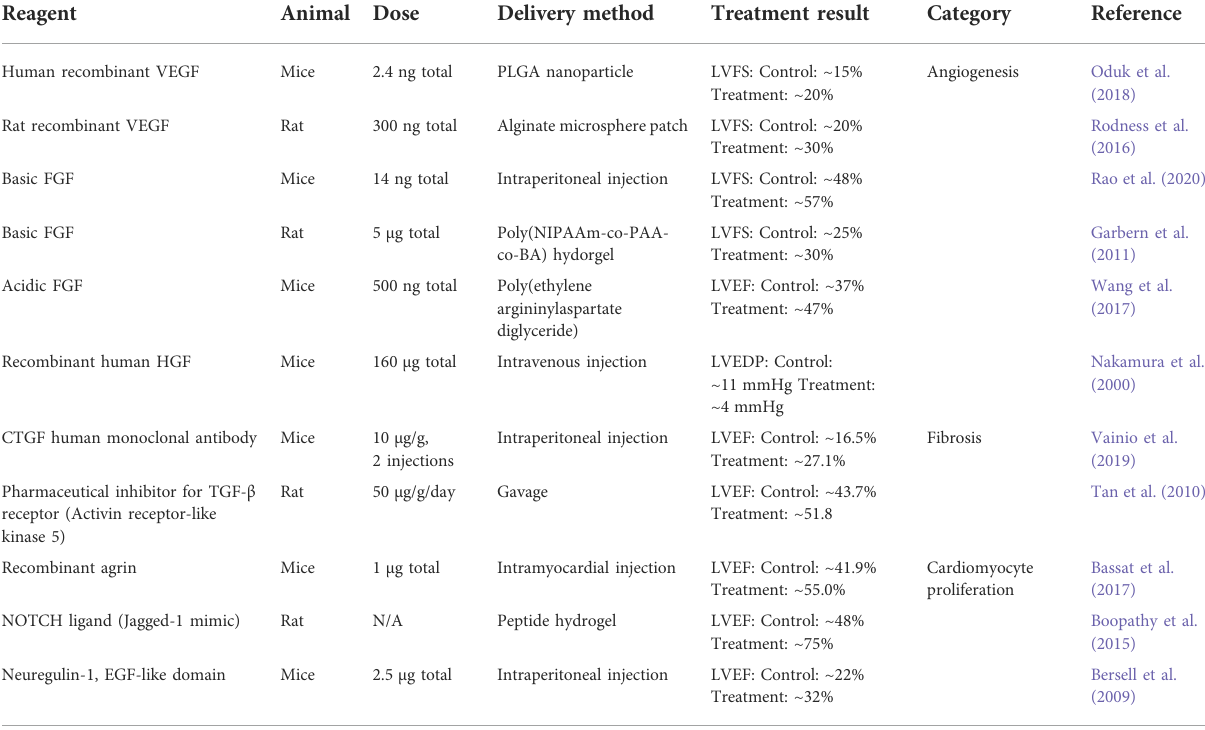
TABLE 1 Potential targets for myocardial infarction mRNA